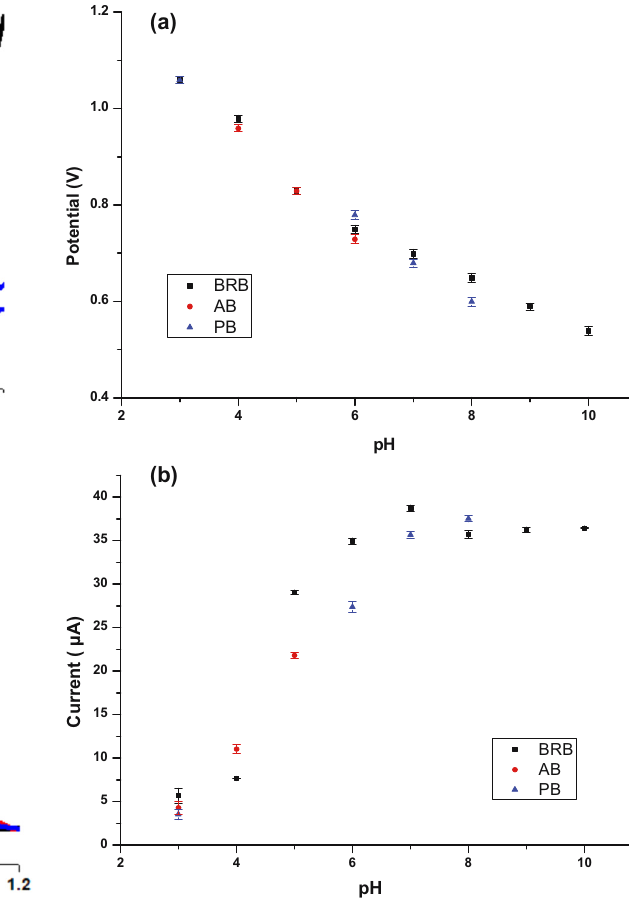
Figure 2: In fl uence of pH values on ( a ) peak potential and ( b ) peak current values of 1.0 × 10 − 4 M SUL with SWV using GO/ β - CD mod - i fi ed